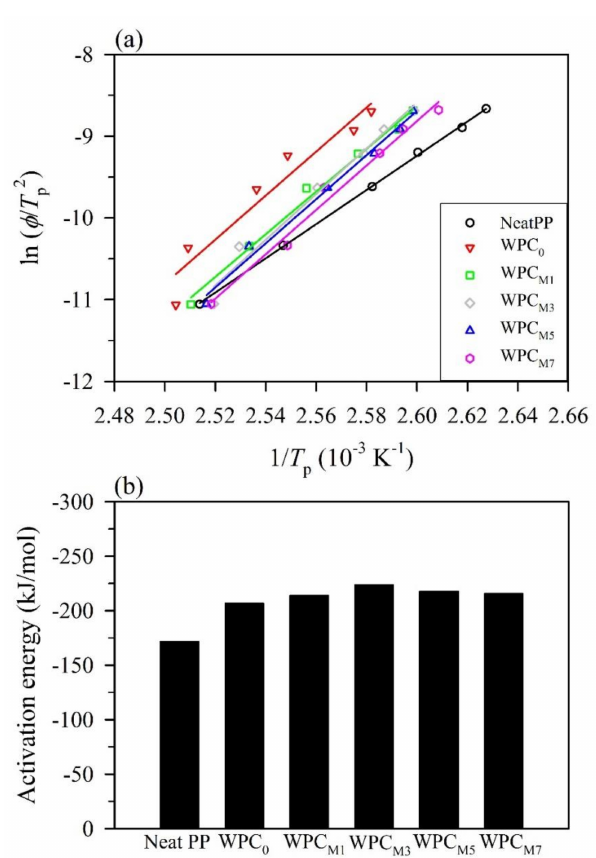
Figure 4. The non-isothermal crystallization kinetics of the neat PP and WPCs using the Kissinger method. ( a ) Kissinger plots of ln ( φ / T p2 ) versus 1/ T p2 ; ( b ) the crystallization activation